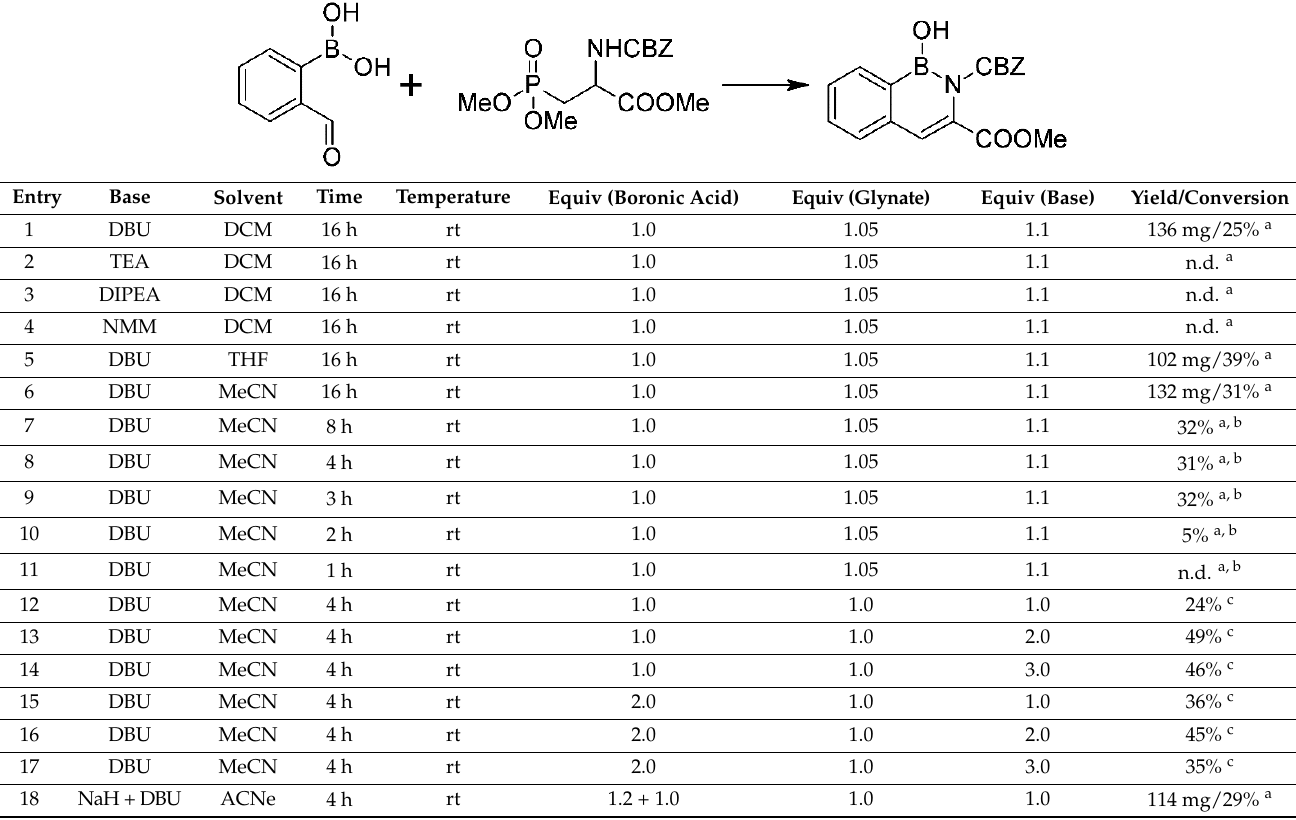
Table 1. Optimization of the base for the synthesis of 1 .